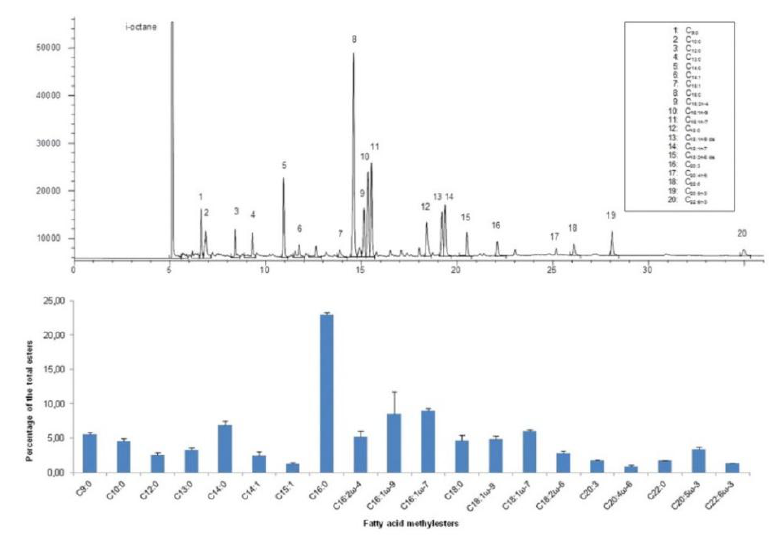
Figure 3. Composition and content (%) of fatty acids in algal biomass mean values (n = 6; ± SE).